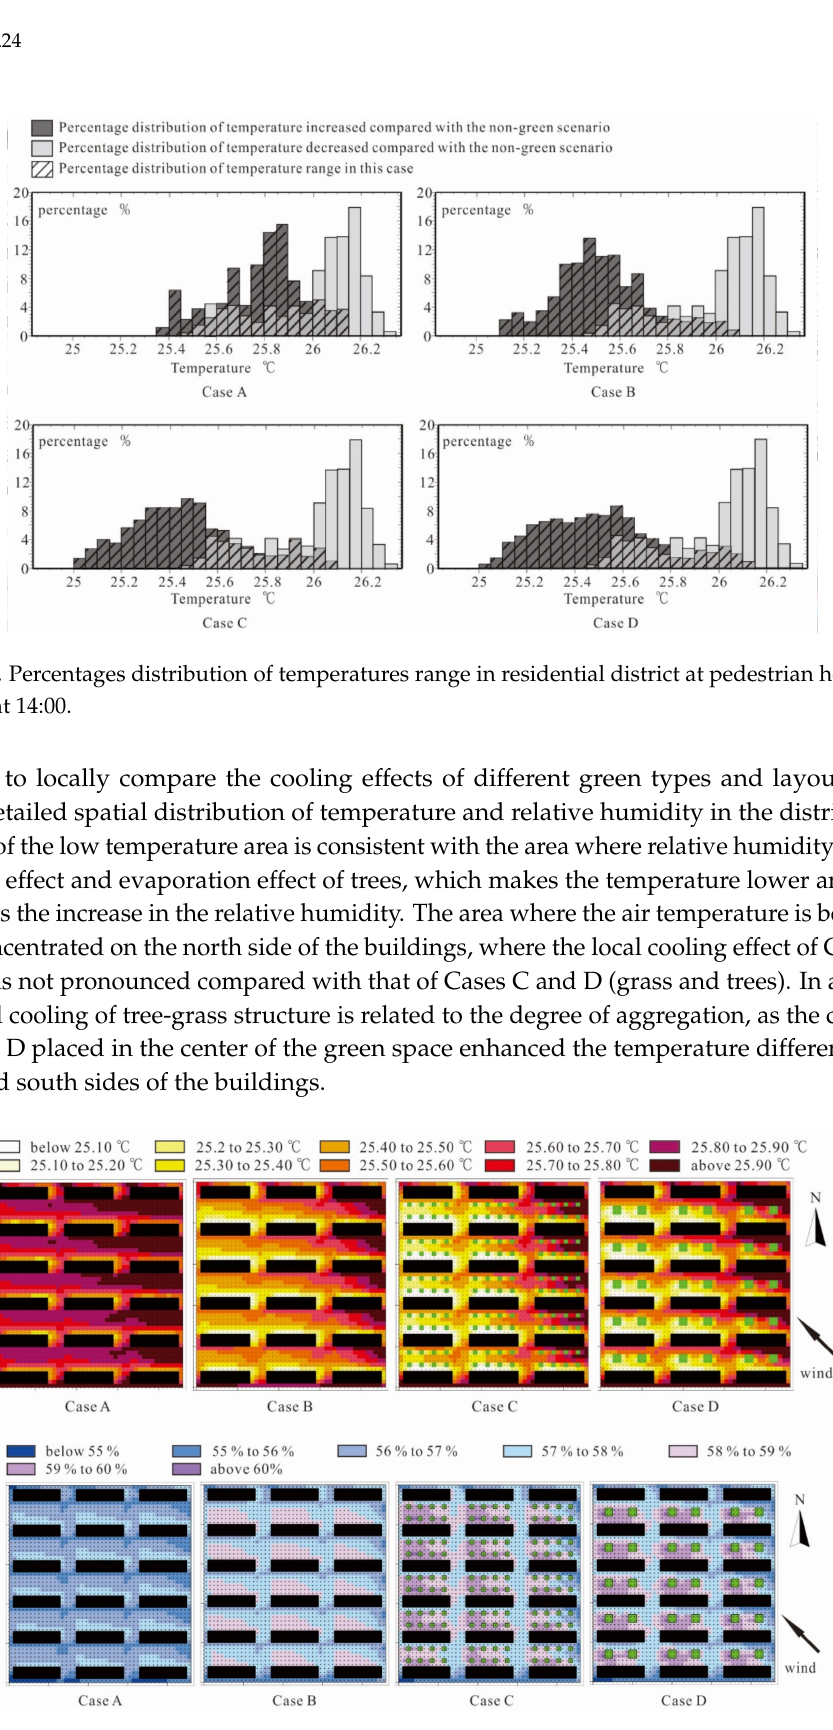
Figure 8. Contours of temperature distribution ( top ) and relative humidity ( bottom ) in the residential district at pedestrian height on 23 June at